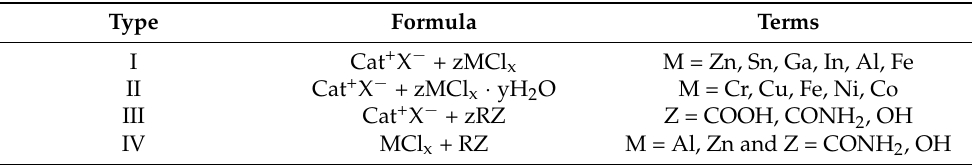
Table 1. The four types of Deep Eutectic Solvents and their